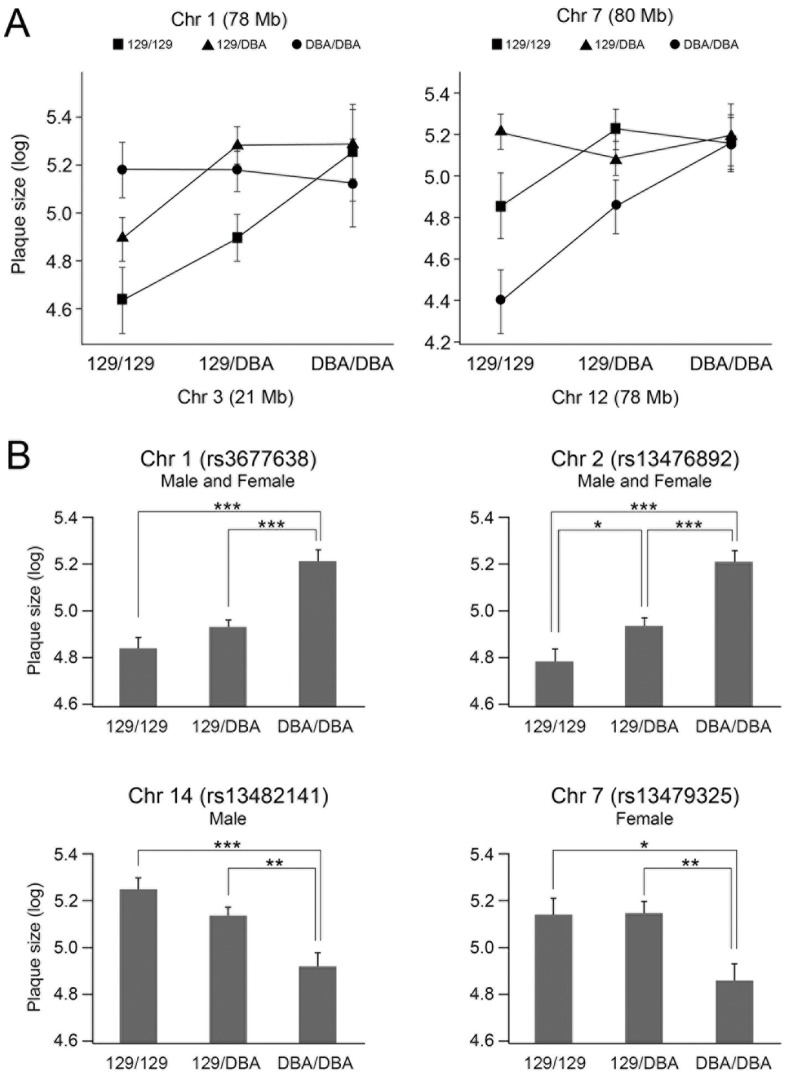
Allele effects of QTL for atherosclerosis.(A) Allelic distribution of the main effect QTL for atherosclerosis at the root in Chr 1 and Chr 2 in both sexes, Chr 14 in males, and Chr 7 in females. Atherosclerotic plaque sizes are indicated as the mean ± SEM. *p<0.05, **p<0.01, ***p<0.001. (B) The effects of interactions detected by the pair-wise genome scan on the plaque size (μm2) expressed in log. Interactions between Chr 1 and Chr 3 in females (left) and interactions between Chr 7 and Chr 12 in females (right).